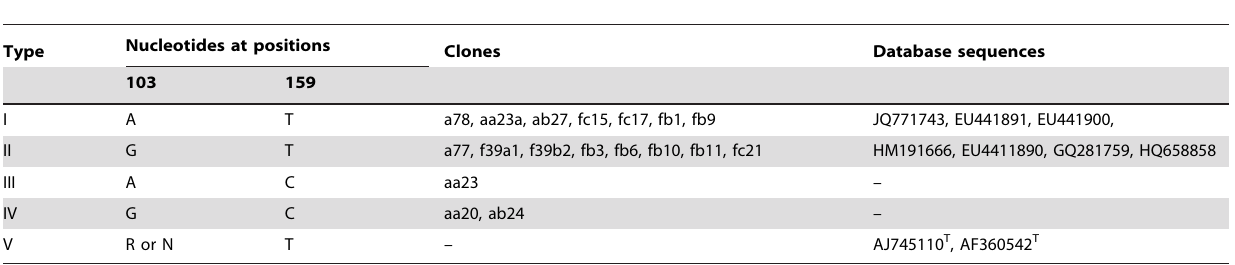
Table 4. Compensatory nucleotide substitutions in